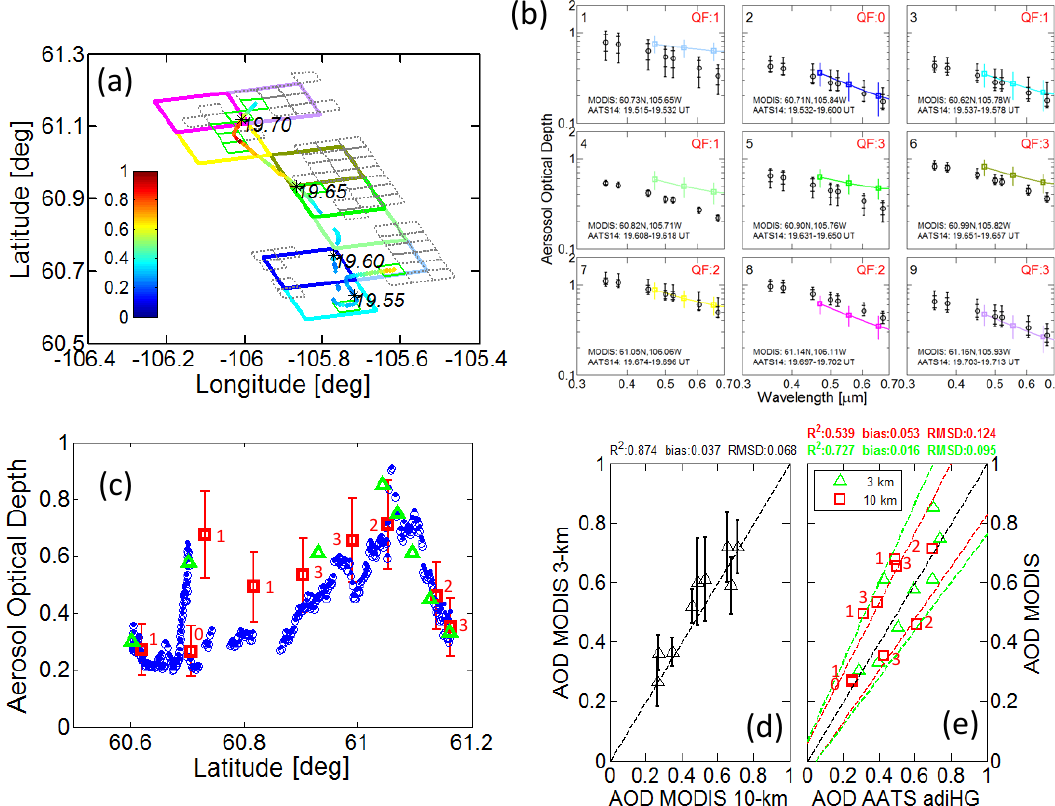
Fig. 12. Analogous to Figs. 9 and 10 but for the 9 July Aqua MODIS–AATS AOD comparison. MODIS retrieval quality flags are listed in red in (b) , (c) , and (e) Figure 12. Analogous to Figs. 9 and 10, but for the 09 July Aqua MODIS/AATS AOD comparison. MODIS retrieval quality flags are listed in red in (b), (c), and (e).